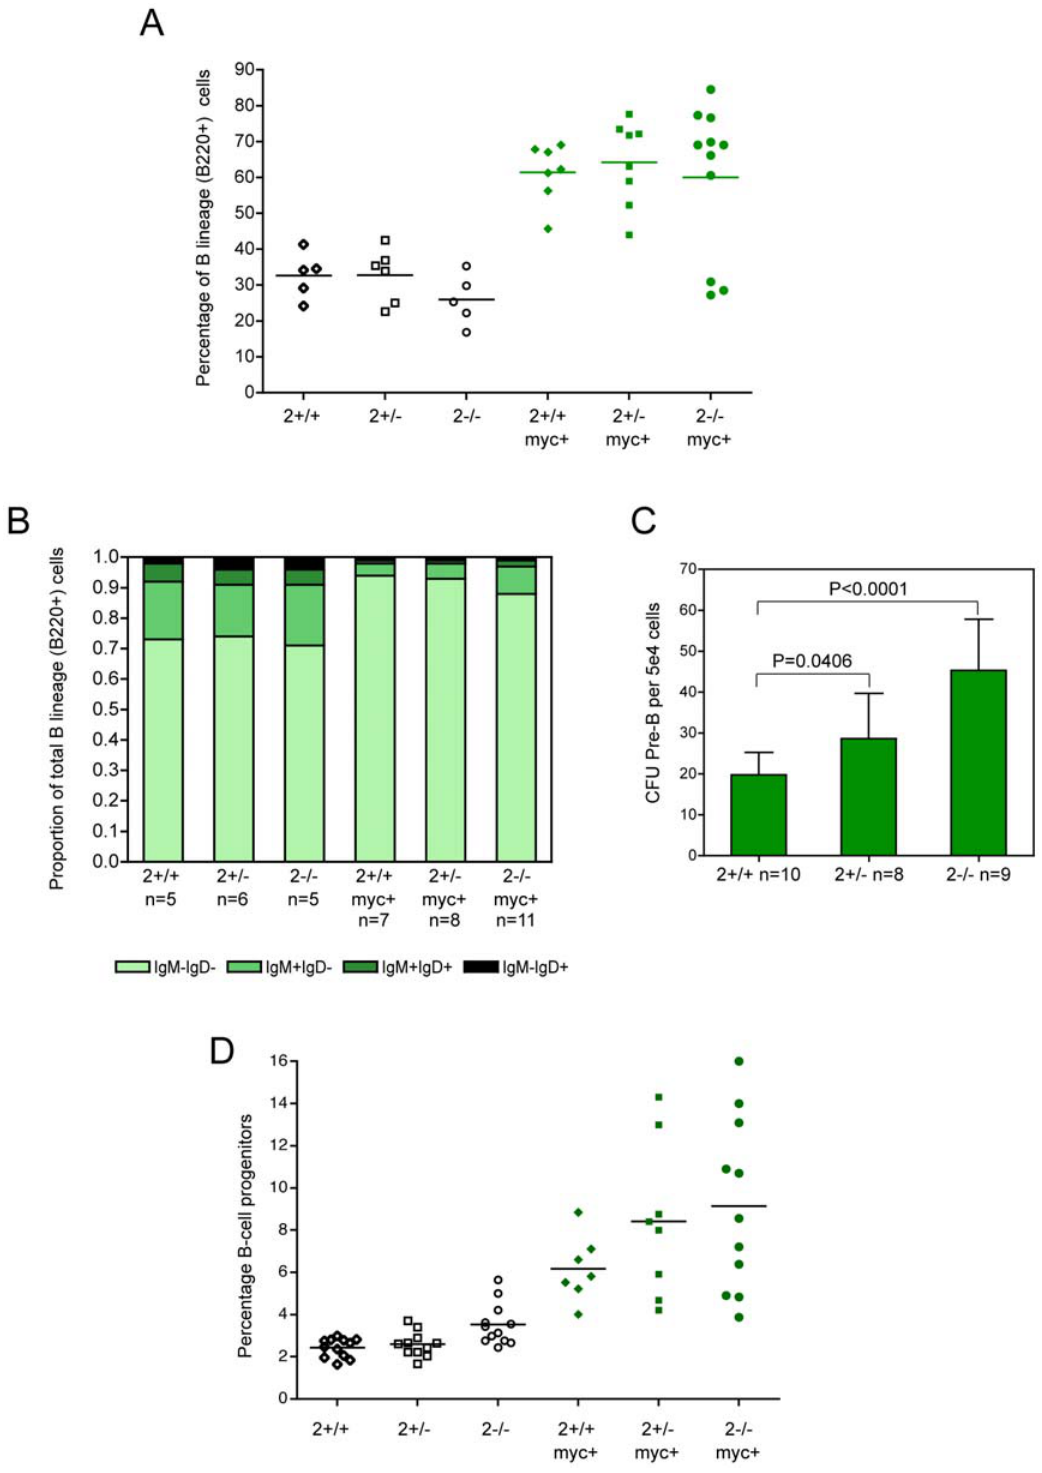
Figure 4. Overall expansion of the B-lineage in response to Myc is not altered by E2F2 status, but E2f2 -deficient mice have more progenitor B cells. (A) The percentage of B-lineage cells (B220 + ) within the bone marrow of normal and pretumorous mice with the indicated genotypes. (B) Proportions of bone marrow B lineage cell populations (B220 + ), from early to more mature stages, across the E2F2 cohort: surface immunoglobulin negative cells, IgM positive IgD negative cells, IgM positive IgD positive cells, and IgM negative IgD positive cells. (C) For clonogenic pre-B cell progenitor assays, an equivalent number of whole bone marrow cells from 8-week old E2f2 + / + , E2f2 + / 2 , and E2f2 2 / 2 littermates were plated in methylcellulose formulated for pre-B progenitors. After seven days, the number of progenitors (CFU pre-B) per 5 6 10 4 input cells was determined by counting the B lineage colonies that had arisen. (D) The proportion of immature B lineage cells (B220 + CD43 + ) in the bone marrow of normal and pretumorous E2F2 cohort mice of the indicated genotypes.